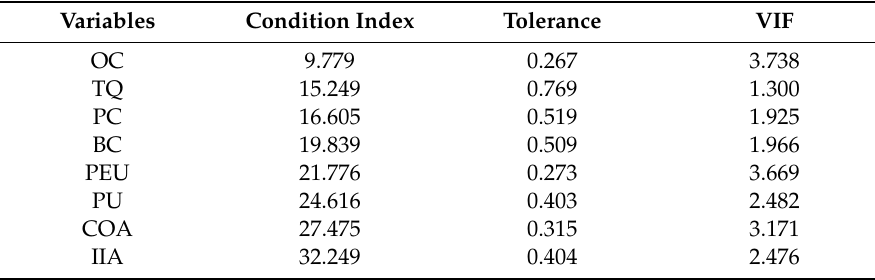
Table 5. Results of multi-collinearity diagnosis.